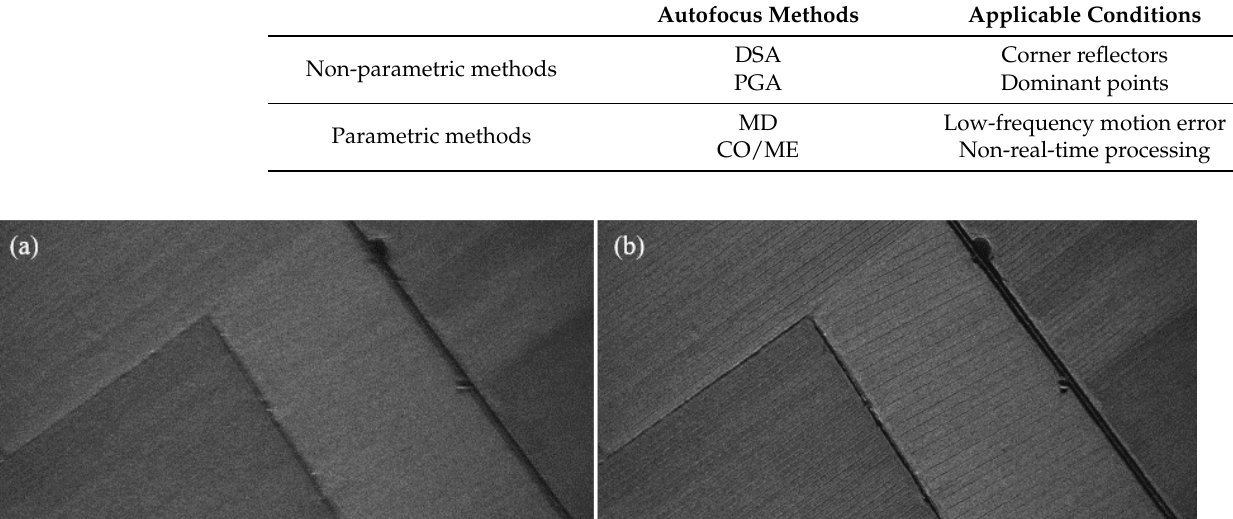
Figure 1. Autofocus imageries of scene type #1 by the non-parametric method ( a ) and parametric method ( b ).